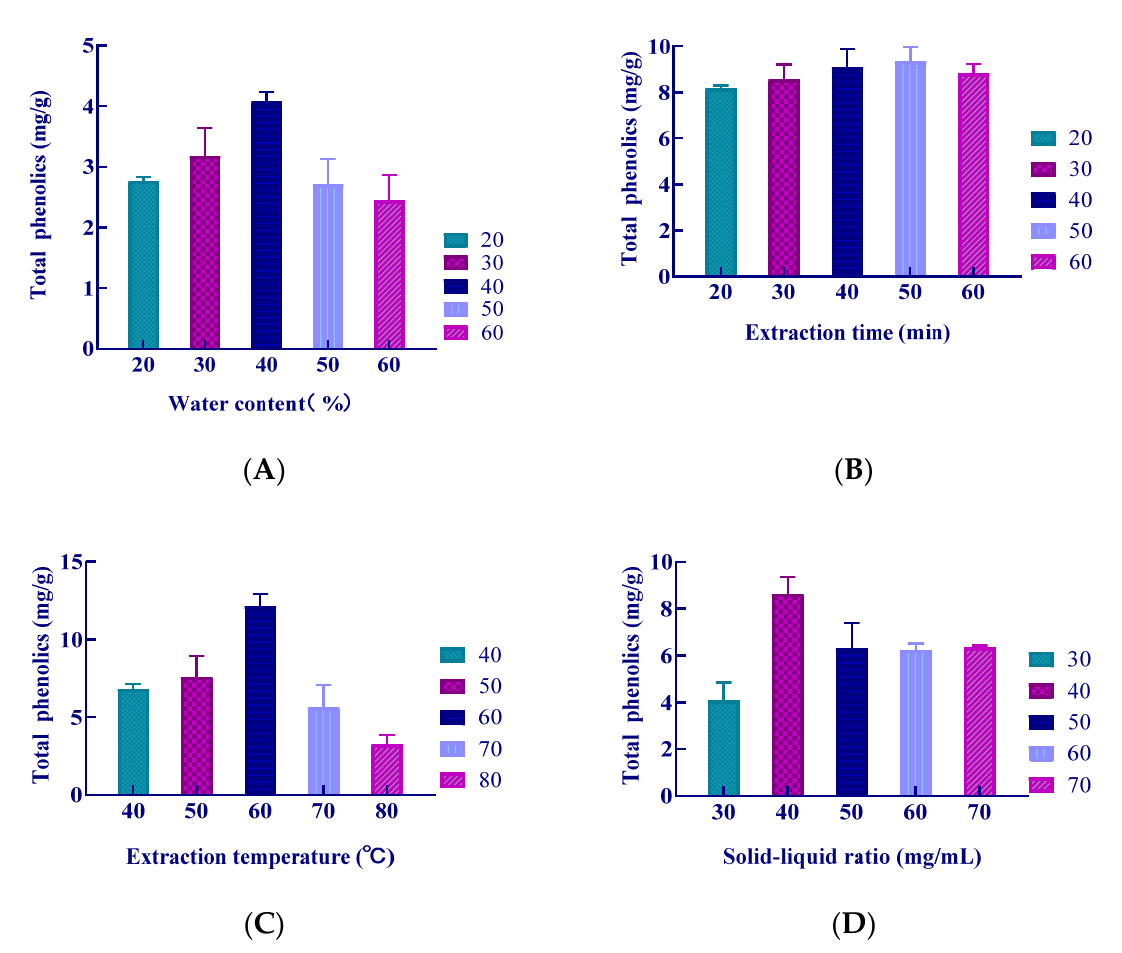
Figure 3. Effect of different extraction conditions on the extraction yield of polyphenols.